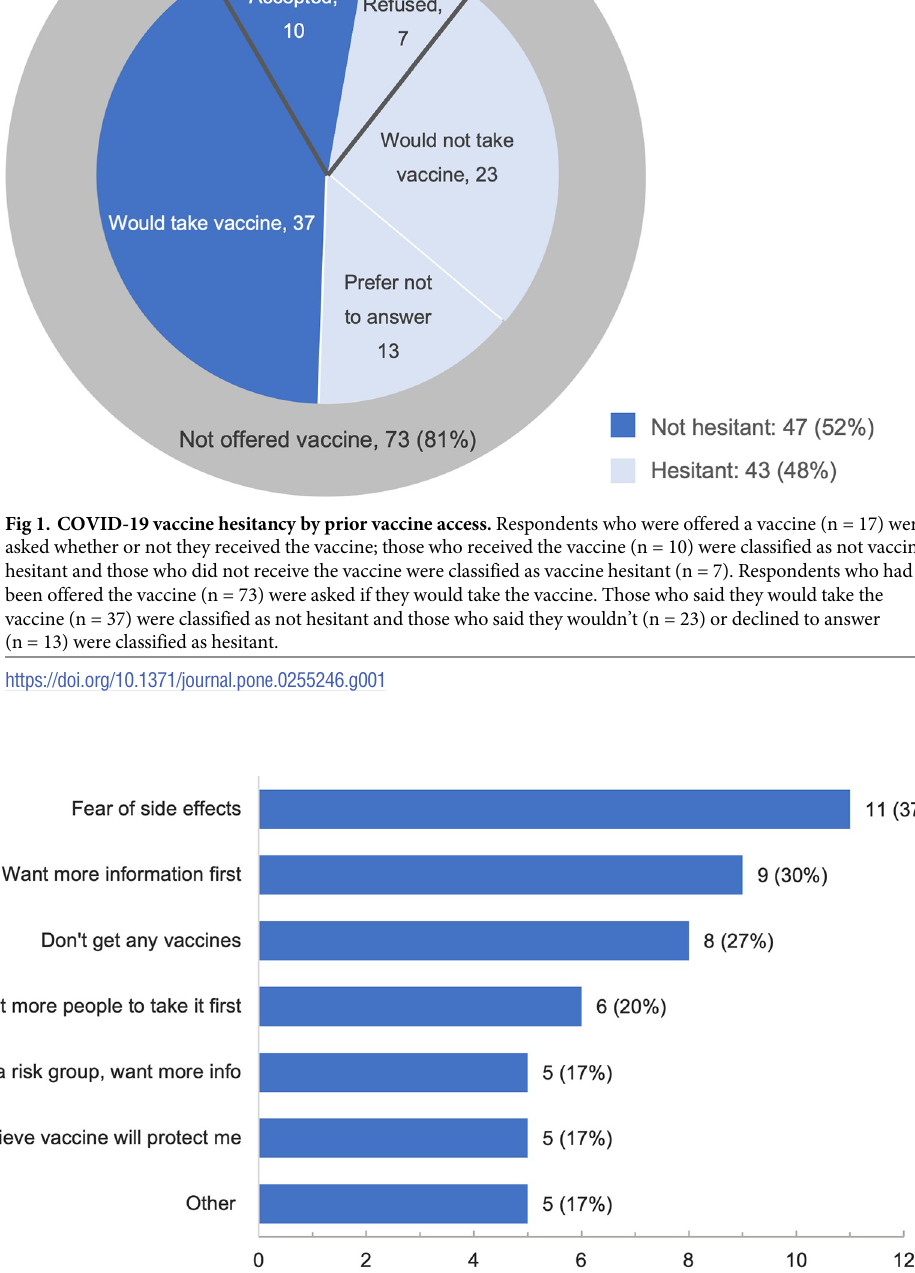
PLOS ONE | https://doi.org/10.1371/journal.pone.0255246 July 30,